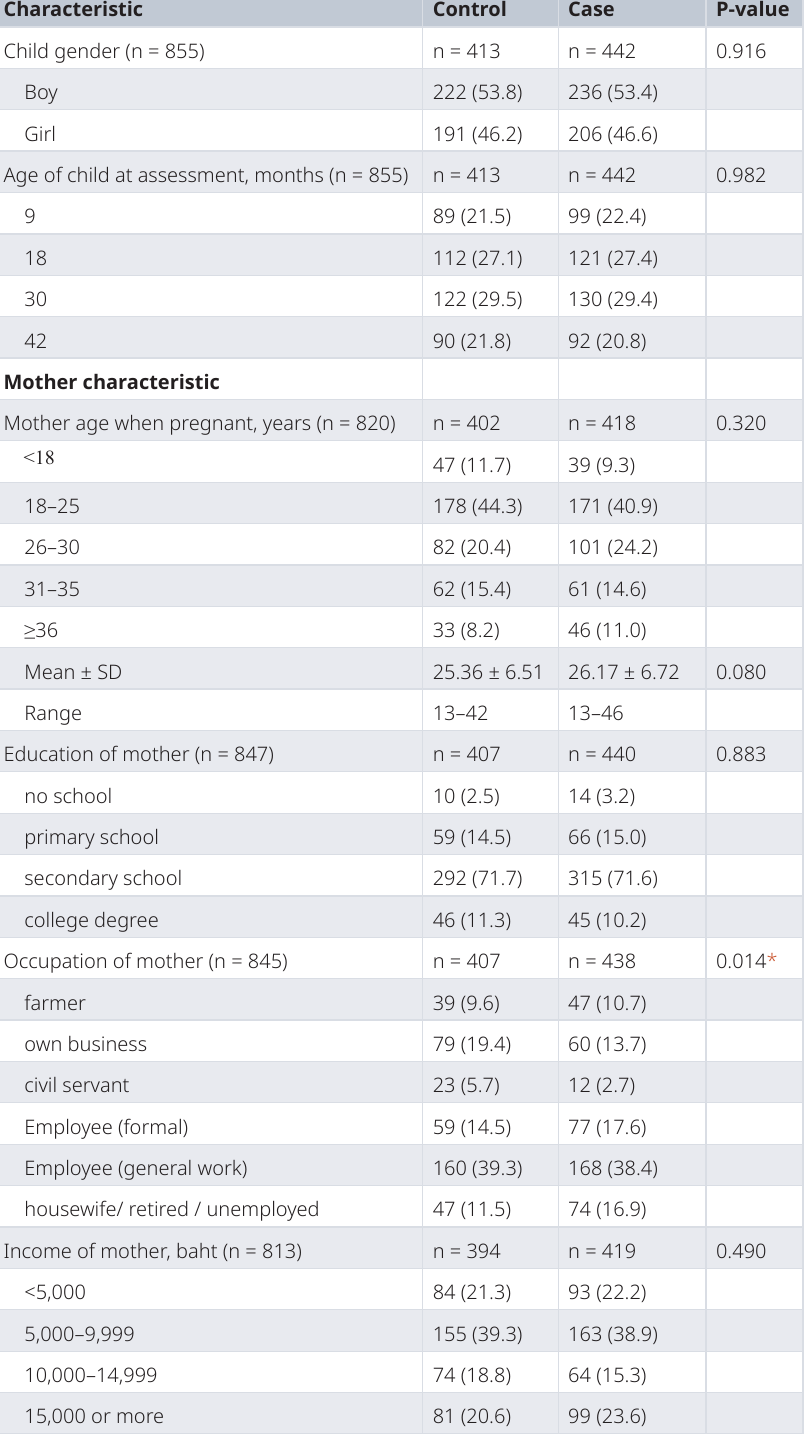
Table 1. Demographic characteristics and some exposure factors of the study participants.